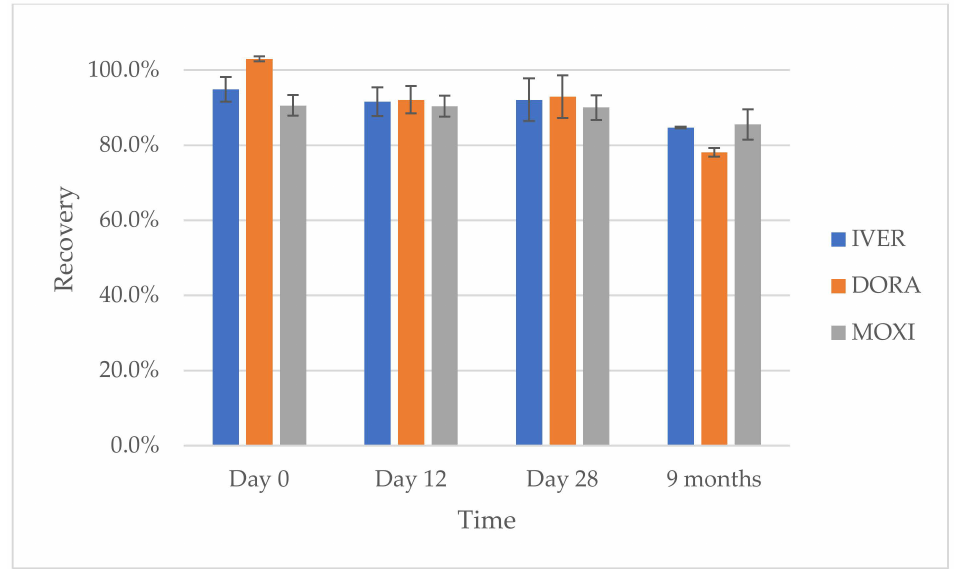
Figure 4. Analyte recovery of ivermectin (IVER), doramectin (DORA), and moxidectin (MOXI) in acidified bovine plasma (0.5% formic acid in plasma matrix, pH ~4) after long-term storage at ≤− 15 ◦ C.